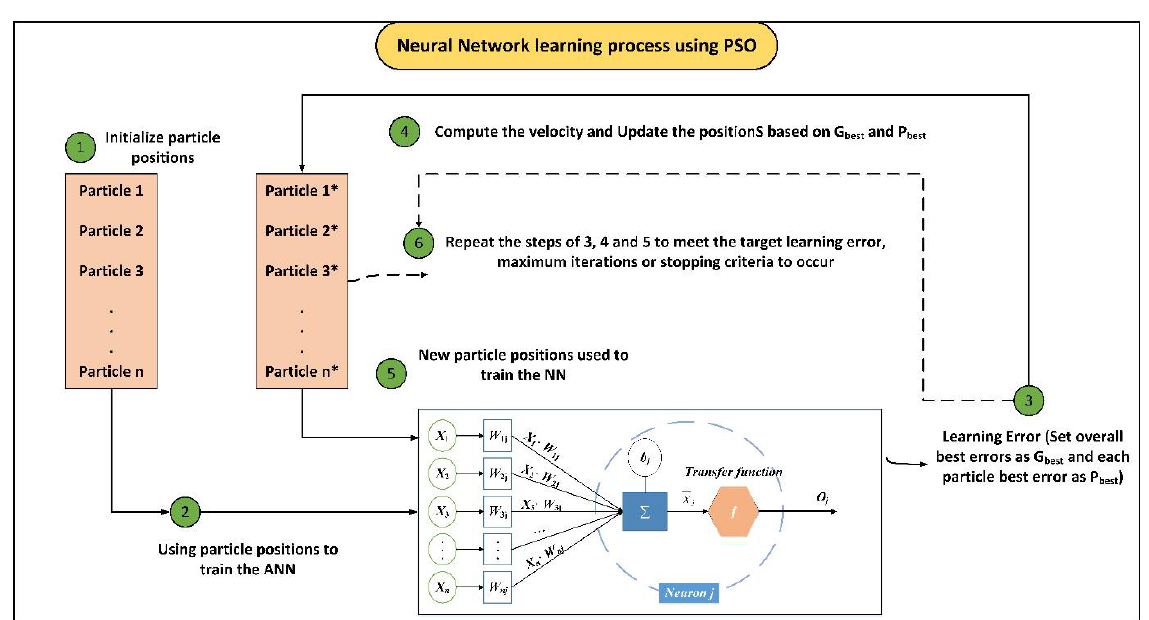
Figure 4. PSO-ANN algorithm.